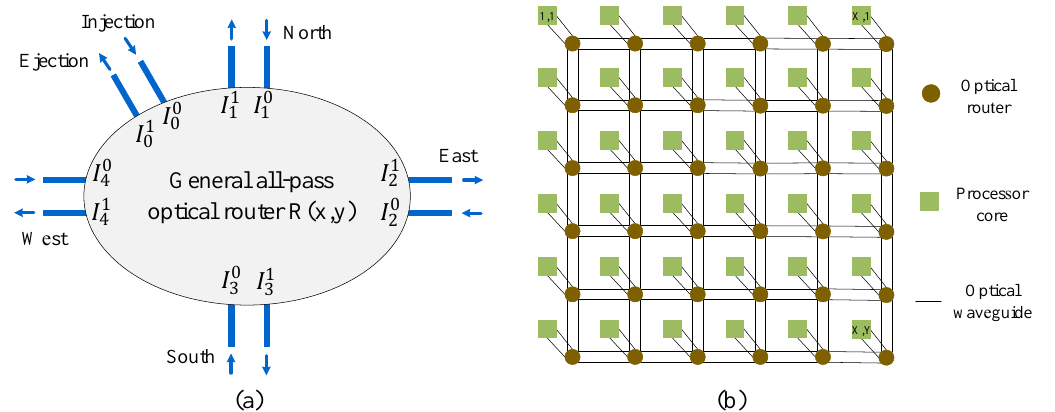
Figure 2. ( a ) General 5 × 5 optical router model; ( b ) The X × Y 2-D mesh-based